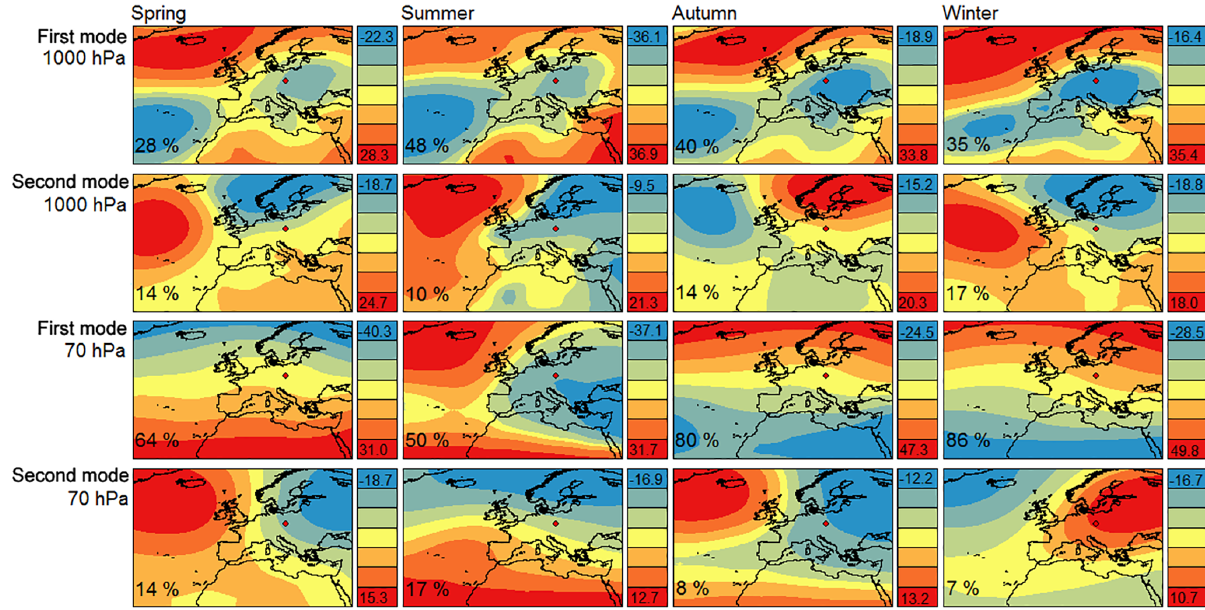
Figure 5. The values of the first and second PCA modes of the 1000 and 70hPa geopotential heights for the days with EUV 90 + in spring, summer, autumn, and winter (represented by the color legend on the right). Variability explained by each of the modes is indicated by the relative value in the bottom-left corner. The red dot marks the location of the Hradec Králové